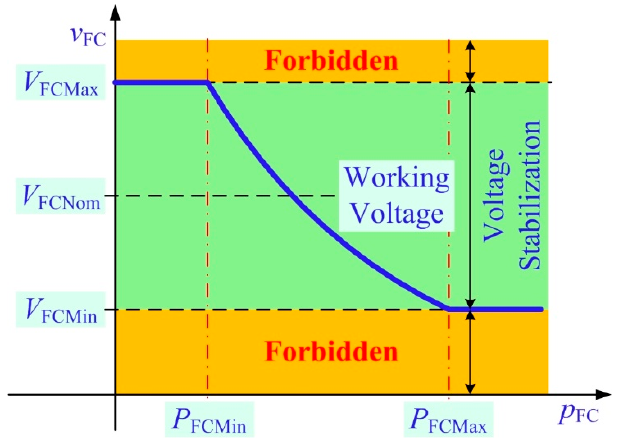
Figure 4. Definition of the FC voltages: V FCMin , V FCNom , V FCMax .